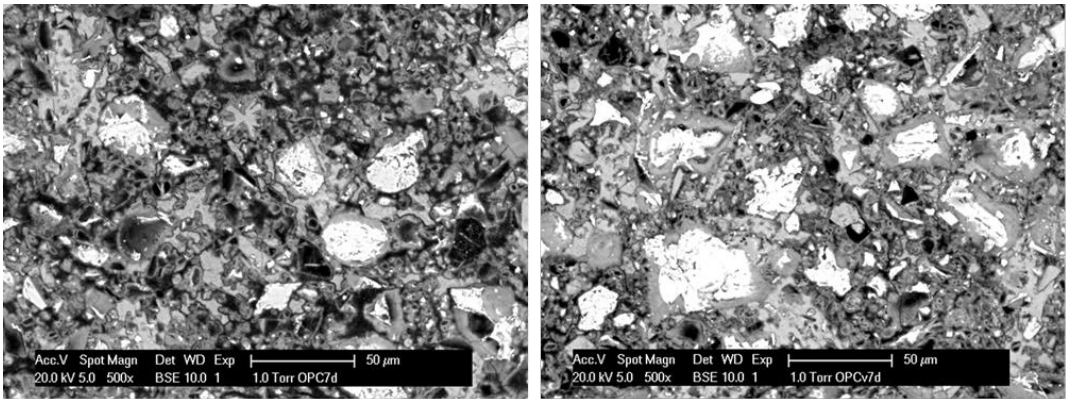
Figure 8. Cement-based bulk matrix (impregnated and polished cross sections of mortar specimens, as usually used for ESEM image analysis) without ( left ) and with ( right ) admixed nanoparticles (vesicles) at seven days of hydration age (black color represents pores and voids in the matrix, white color represents un-hydrated phases (cement grains), the grey colored features represent hydration products (e.g., C-S-H, Ca(OH) 2 ; for image analysis of the bulk matrix, aggregates (as sand, gravel and relevant interfacial transition zones ITZs) are to be excluded, therefore the images do not present aggregates or interfaces).